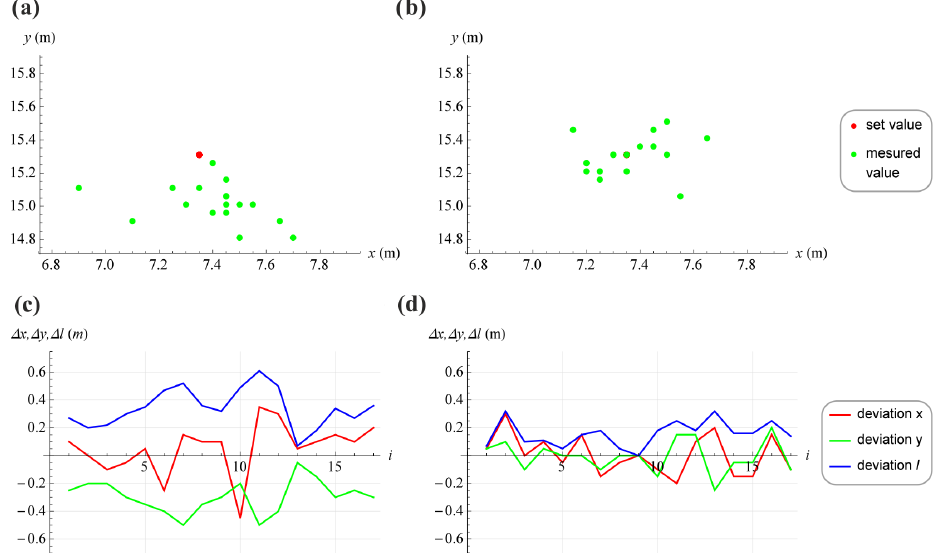
Figure 10. Accuracy measurement of point 3.( a ) Green points represent measured positions when the robot stops. The red point is an aim point. In this experiment, the robot had thre vision system turned off. ( b ) The robot had the vision system turned on. ( c ) Deviations from the aim point in x and y , where the vision system was off. ( d ) Deviations from the point where the vision system was